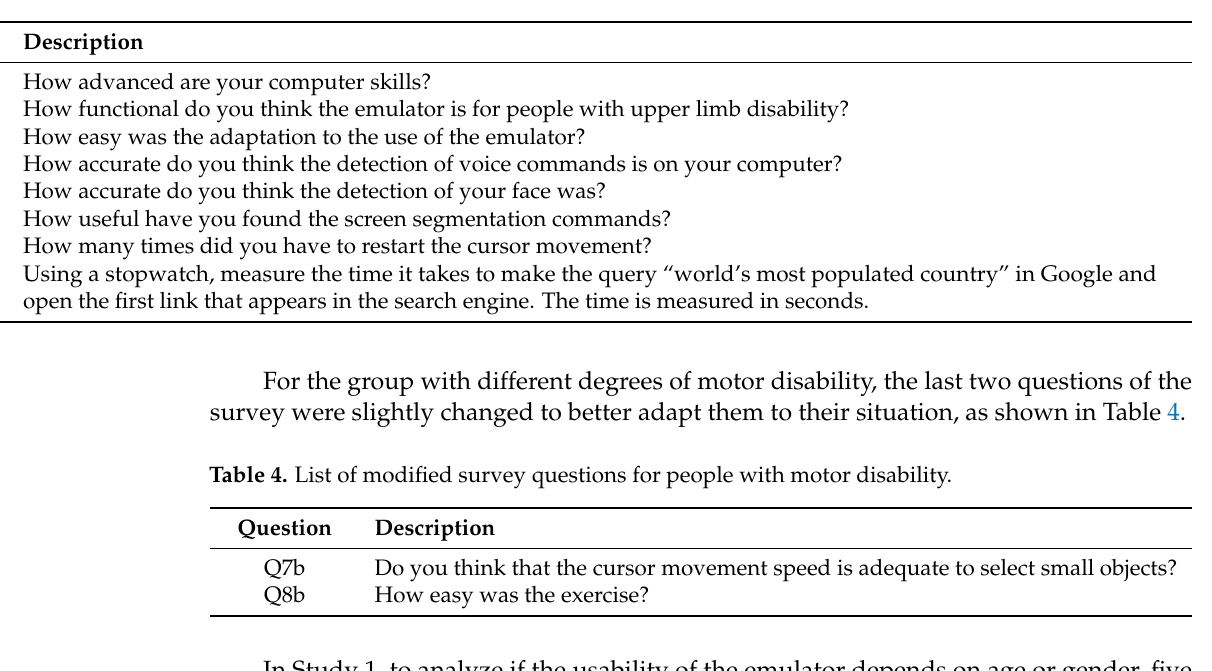
Table 3. List of survey questions.